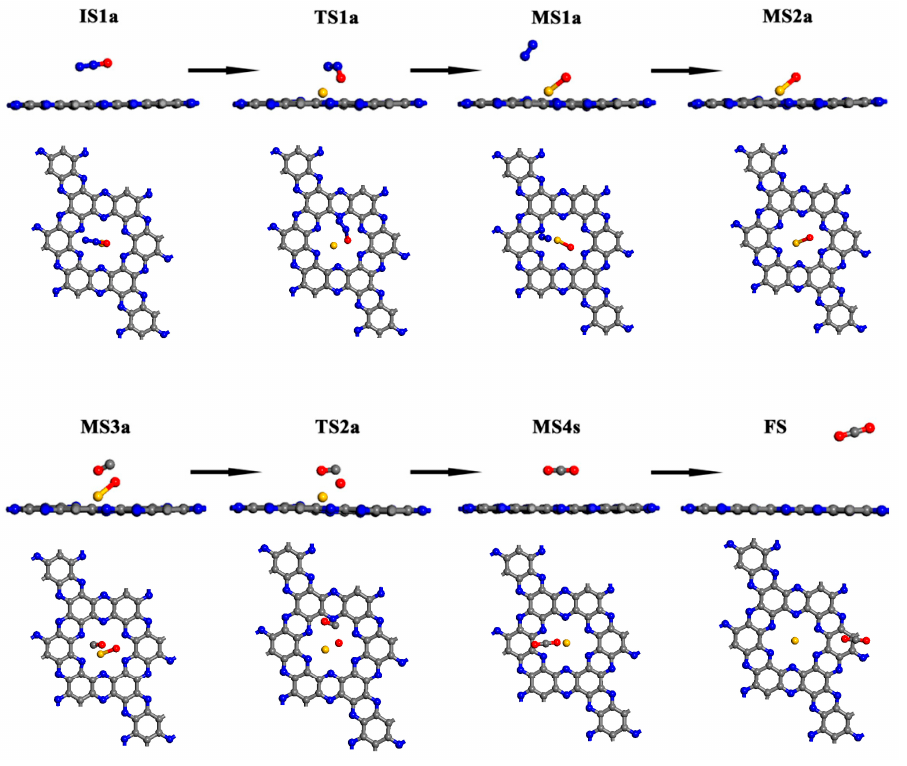
Figure 2. The schematic diagram of all species along the MEP for the N 2 O reduction on the Au/C 2 N monolayer via mechanism I. (Blue, grey, yellow and red balls represent N, C, Au and O atoms, respectively.).